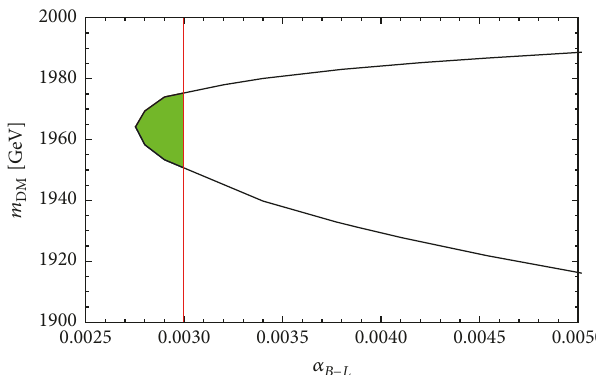
Figure 4: Allowed parameter region for the 𝑍 耠 퐵−퐿 portal dark matter scenario. The solid (black) line shows the lower bound on 𝛼 퐵−퐿 as a Figure 3: The dark matter mass as a function of 𝛼 퐵−퐿 for 𝑚 푍 󸀠 = 4 ℎ 2 = 0.1198 is function of 𝑚 푍 󸀠 to satisfy the cosmological upper bound on the dark TeV. Along the solid (black) curve in each panel, Ω DM matter relic abundance. The dashed line (in red) shows the upper satisfied. The vertical solid line (in red) represents the upper bound bound on 𝛼 퐵−퐿 as a function of 𝑚 푍 󸀠 from the search results for 𝑍 耠 on 𝛼 퐵−퐿 obtained from the ATLAS results [68] (see Figure 4). The ℎ 2 ≤ 0.1198 and the ATLAS boson resonance by the ATLAS collaboration [68]. The LEP bound (green) shaded region satisfies Ω DM is depicted as the dotted line. Combining these bounds, the allowed bound on 𝛼 퐵−퐿 ≤ 0.003 . parameter region is depicted as the (green) shaded region. We also showatheoreticalupperboundon 𝛼 퐵−퐿 (dashed-dotted)toavoidthe Landau pole of the running 𝐵 − 𝐿 gauge coupling below the Planck mass 𝑀 푝푙